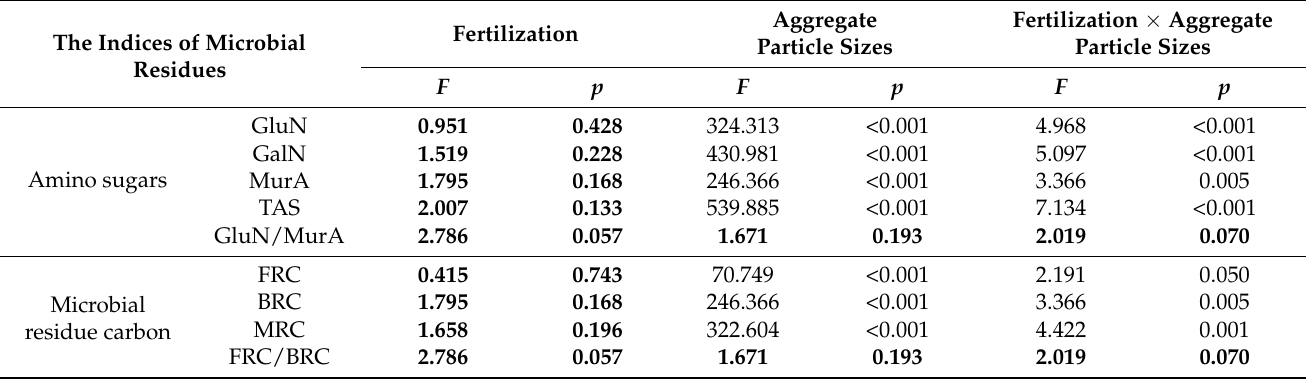
Table 1. Two-way ANOVA for soil amino sugars and microbial residue carbon among four aggregate size fractions under four treatments ( n =